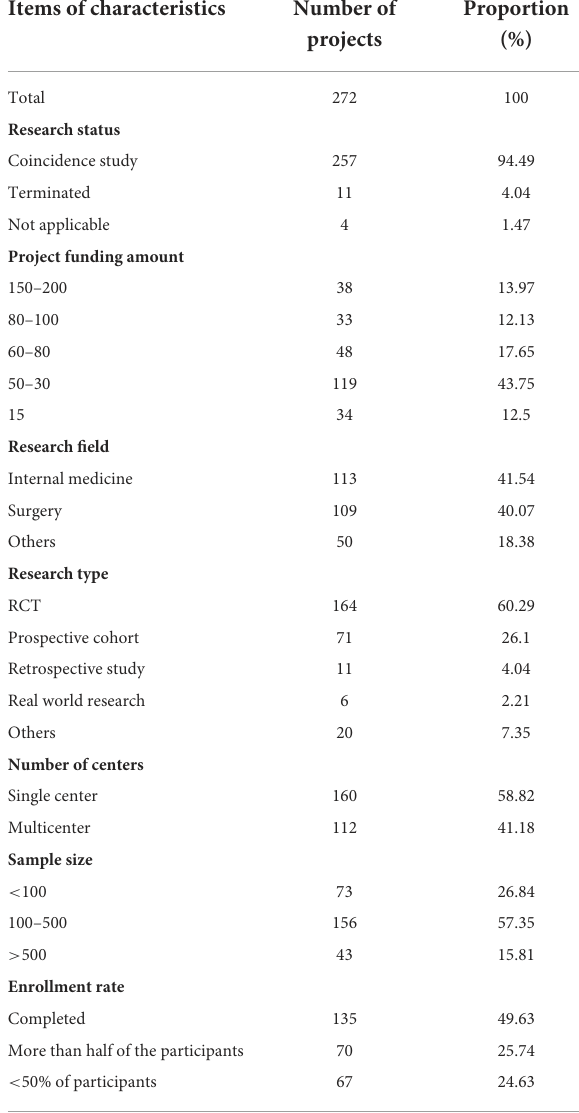
TABLE 2 Basic characteristics of included for investigator-initiated trials validation of quality assessment tool. Items of